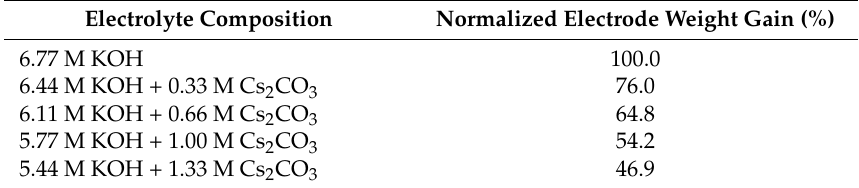
Table 3. Normalized weight gains of the AR3 alloy electrodes cycled in five different electrolytes. Electrolyte Composition Electrolyte